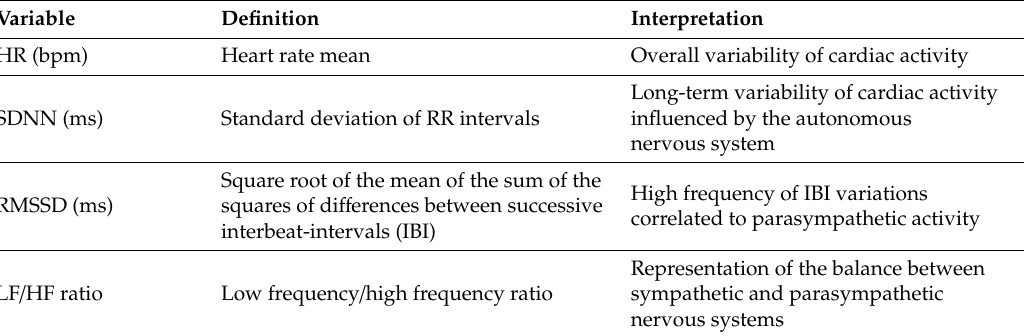
Table 2. Adapted description of HRV variables from Stucke et al., (2015) [29].